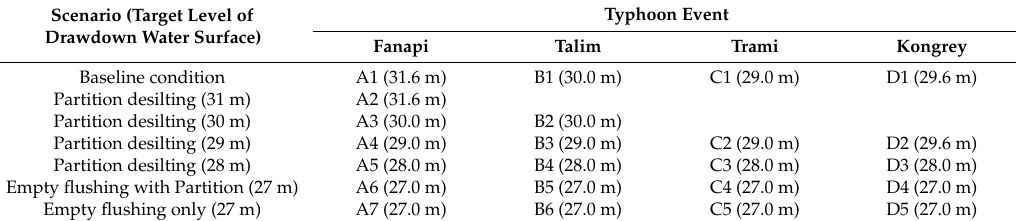
Scenario (Target Level of Drawdown Water Surface)